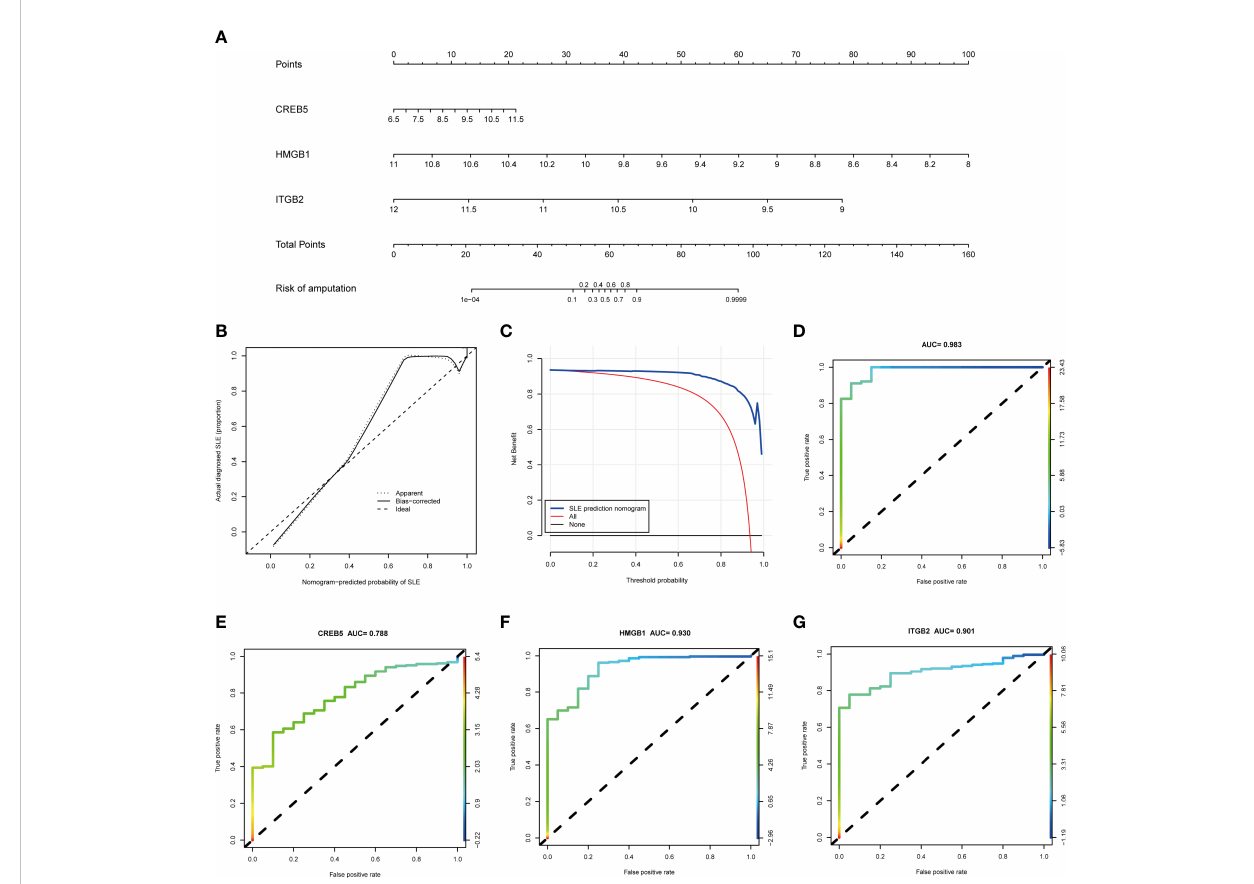
FIGURE 6 The performance of hub genes in the training set. (A) Construction of a nomogram for predicting the occurrence of SLE based on hub genes. (B) Calibration curve. The y-axis is the actual rate of SLE diagnosis and the x-axis is the predicted risk of SLE. The diagonal dotted line represents a perfect prediction by an ideal model. The solid line represents the bias − corrected performance of the nomogram, where a closer fi t to the diagonal dotted line represents a better prediction. (C) Decision curve analysis. The blue represents the net bene fi t of the nomogram in the prediction of SLE occurrence. The red line represents the assumption that all people have SLE. The black line represents the assumption that all people do not have SLE. (D) ROC curve of the three hub genes combined diagnosis of SLE. (E) ROC curve of CREB5 gene diagnosis of SLE; (F) ROC curve of HMGB1 gene diagnosis of SLE; (G) ROC curve of ITGB2 gene diagnosis of SLE. SLE, systemic lupus erythematosus; ROC, receiver operating